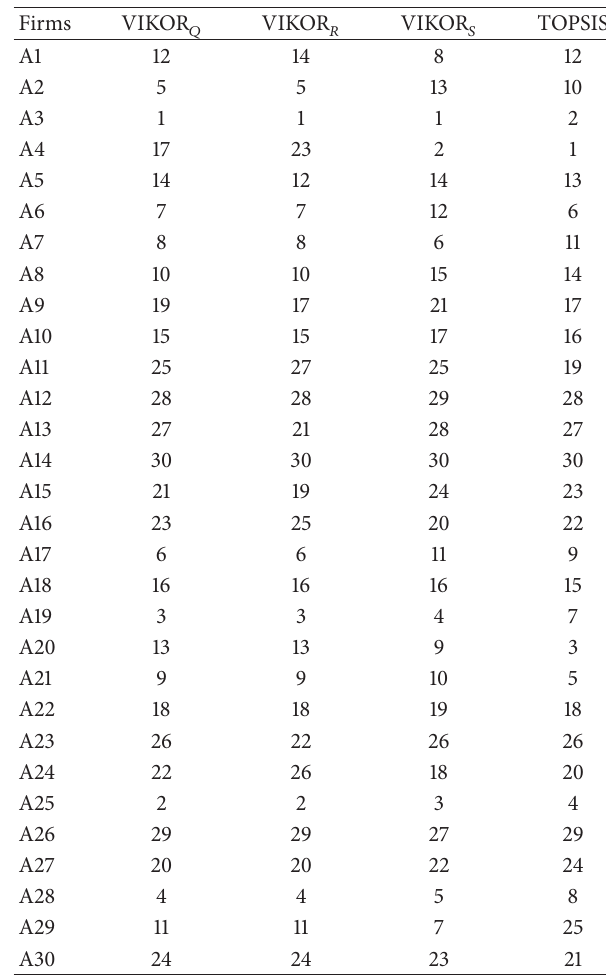
Table 10: Comparison of VIKOR and